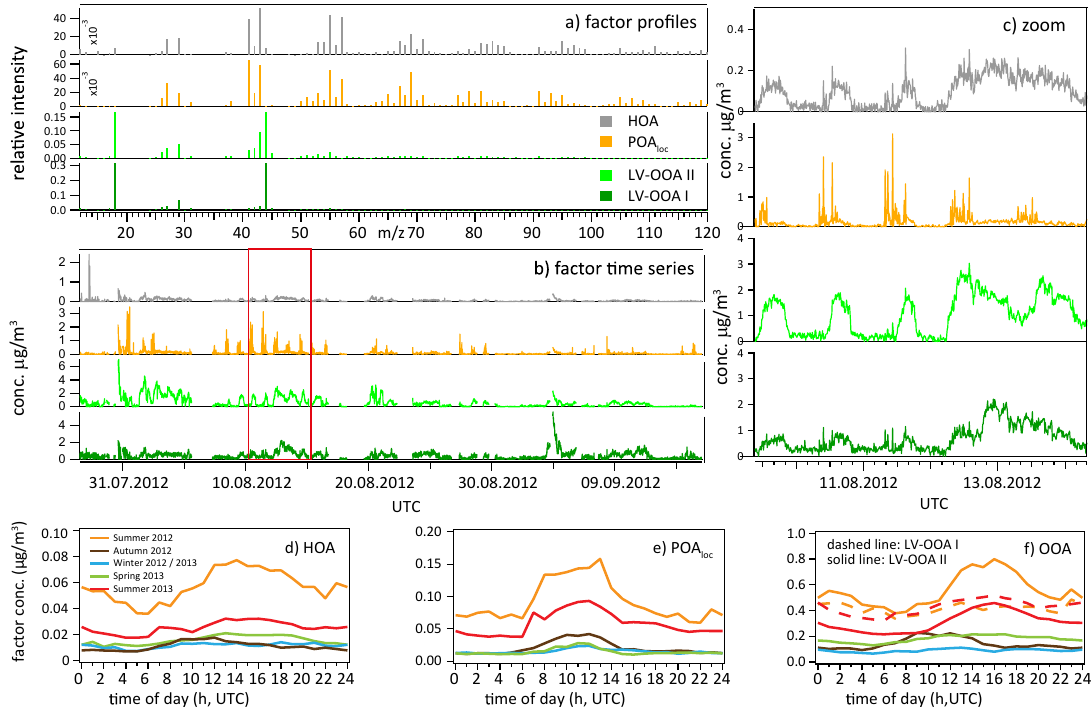
Figure 8. ME-2 example solution for summer 2012 and diurnal plots. (a) Factor profiles of HOA (grey), POA loc (orange), LV-OOA I (dark green) and LV-OOA II (light green). (b) Factor time series of HOA, POA loc , LV-OOA II and LV-OOA I. (c) Zoom of the region indicated in red (about 5 days) in the time series plot. (d) HOA diurnal cycles for all seasons. Orange: summer 2012; brown: autumn 2012; blue: winter 2012/2013; green: spring 2013; red: summer 2013. (e) POA loc diurnal cycles for all seasons. (f) OOA diurnal cycles for all seasons. Dashed line: LV-OOA I; solid line: LV-OOA II. All times are in UTC.